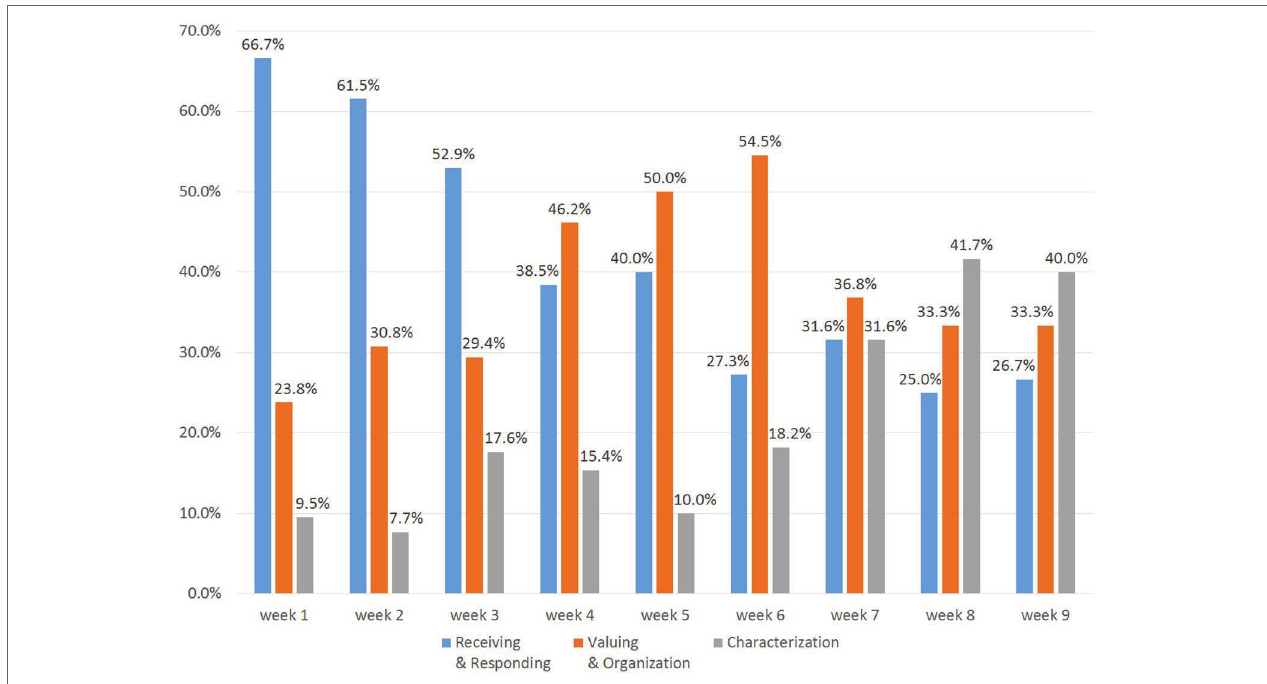
FIGURE 1 | Variation of affective goals.